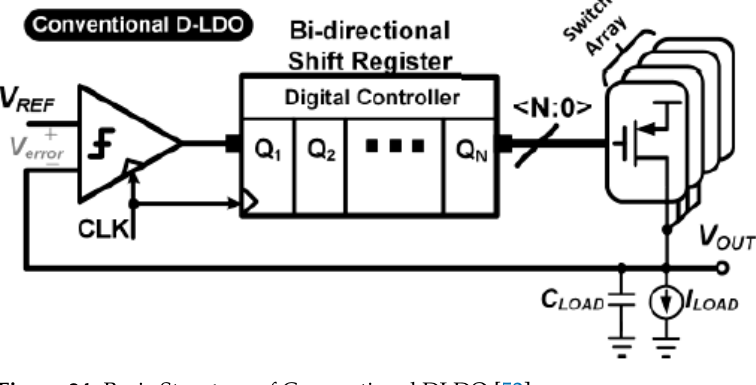
Figure 24. Basic Structure of Conventional DLDO [52].